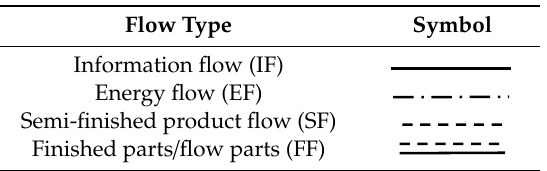
Table 2. Symbols for subsystems and flows.